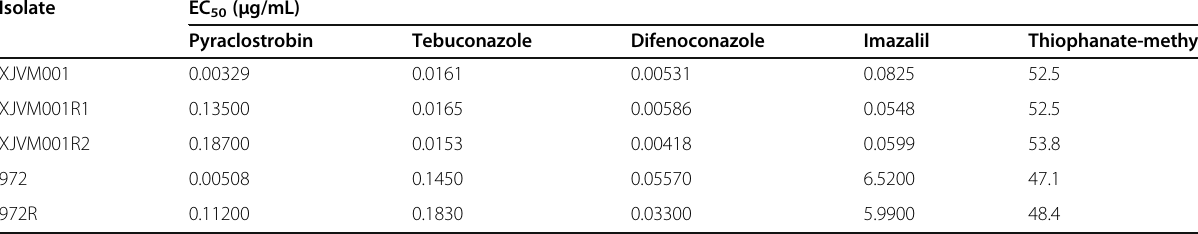
Table 4 Sensitivities of pyraclostrobin-sensitive and pyraclostrobin-resistant mutants of Valsa mali to different fungicides Isolate